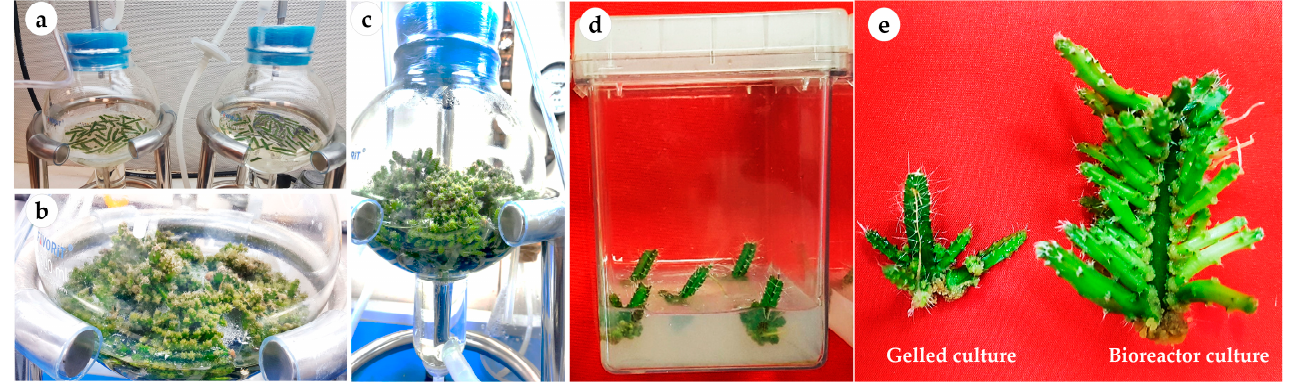
Figure 2. Multiplication and growth of H. polyrhizus in gelled culture versus bioreactor culture after 8 weeks. ( a ) Continuous immersion bioreactors at zero day of culture; ( b , c ) axillary cladode growth after 4 and 8 weeks in liquid culture; ( d ) axillary cladode growth after 8 weeks in gelled culture